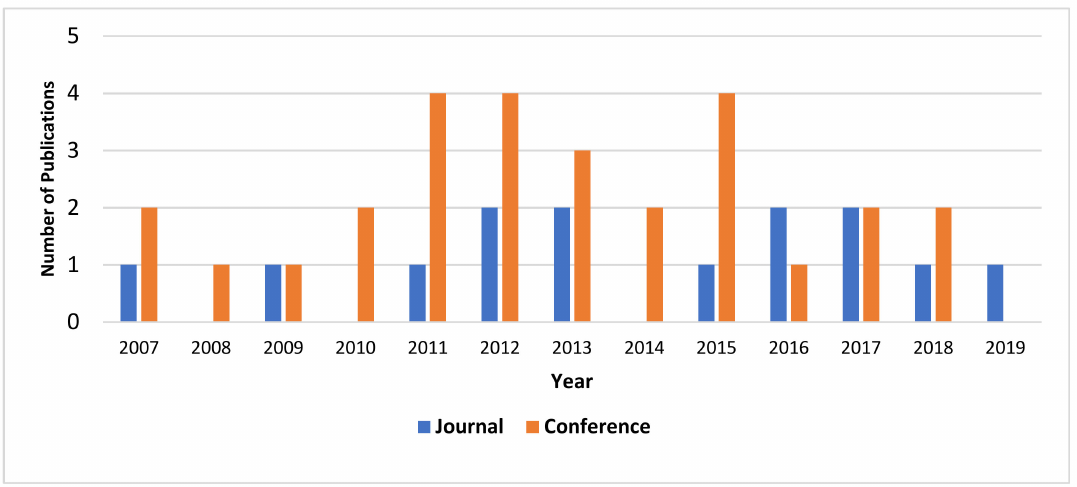
Figure 6. Number of journal and conference publications per